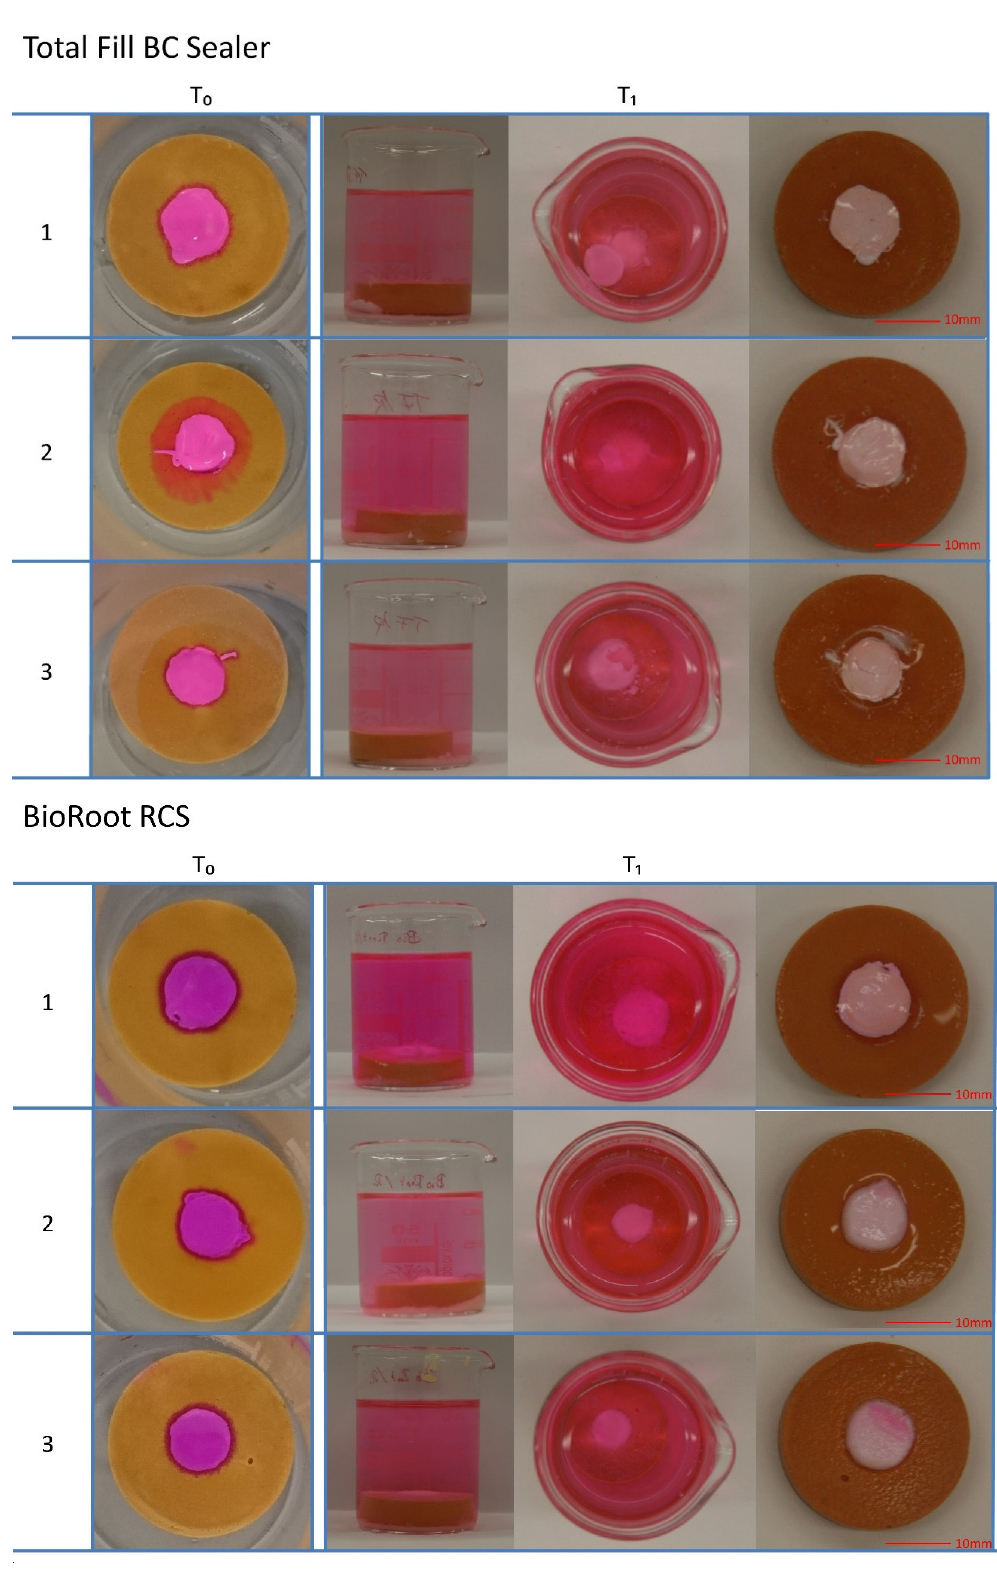
Figure 1. Photographs of the sealers AH Plus, Total Fill BC Sealer, and BioRoot RCS ( n = 3 per sealer) at T 0 (sealers mixed with rhodamine B) and T 1 (sealer after contact with PBS for 7 days). AH Plus was not stained red by rhodamine B dye under dry conditions, while Total Fill BC Sealer and BioRoot RCS presented in a pink color directly after mixing. After the exposure of AH Plus to PBS, the surface turned red. Total Fill BC Sealer and BioRoot RCS lost their coloration after contact with PBS, and the buffer solution turned to a pink